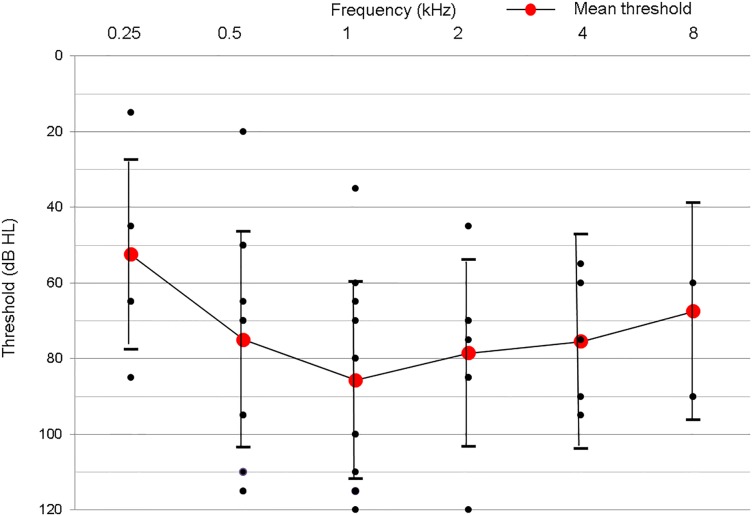
Overlapping audiograms of all patients with GJB2 mutations.All of the patients with hearing loss caused by GJB2 mutations in this study (n = 22). (Black dots mean hearing thresholds of each subject, which may represent more than one subject with identical hearing thresholds. Red dots represent mean hearing thresholds of each frequency).